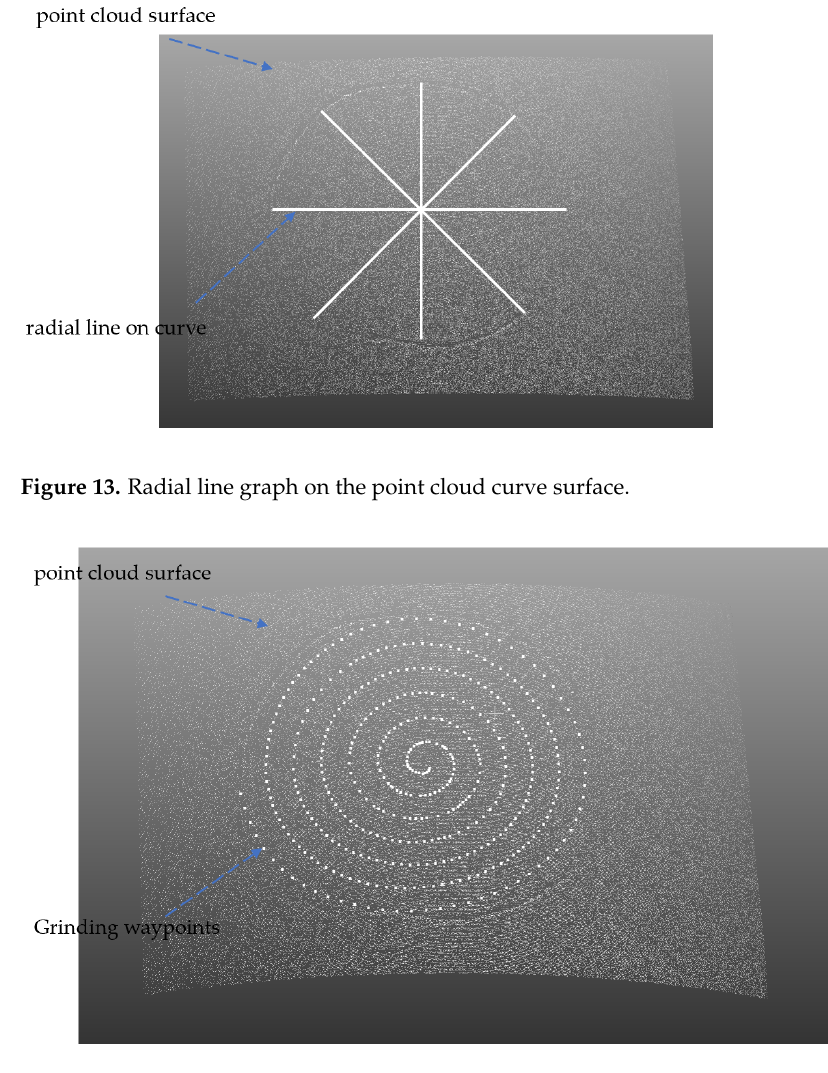
Figure 14. Grinding trajectory points on the point cloud